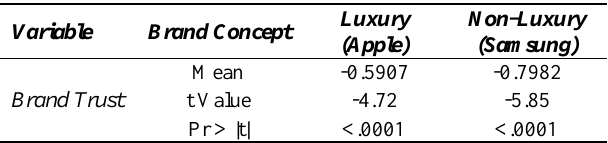
Table 2: Effect of downward brand extension on brand